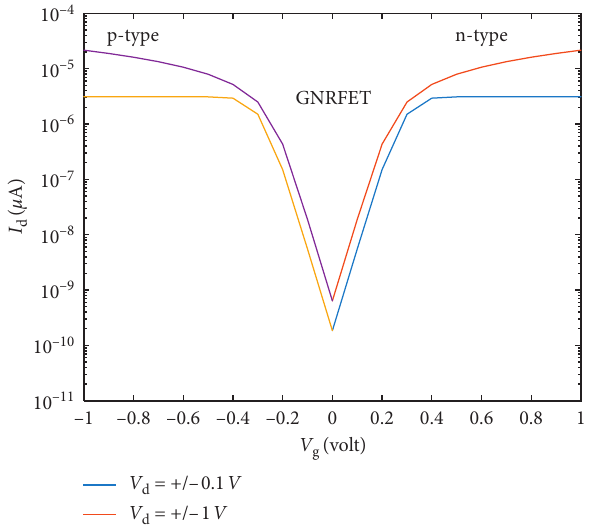
Figure 4: I d - V g transfer characteristics of symmetrical n-type and p-type GNRFETs for | V d | � 0.1V and | V d | �